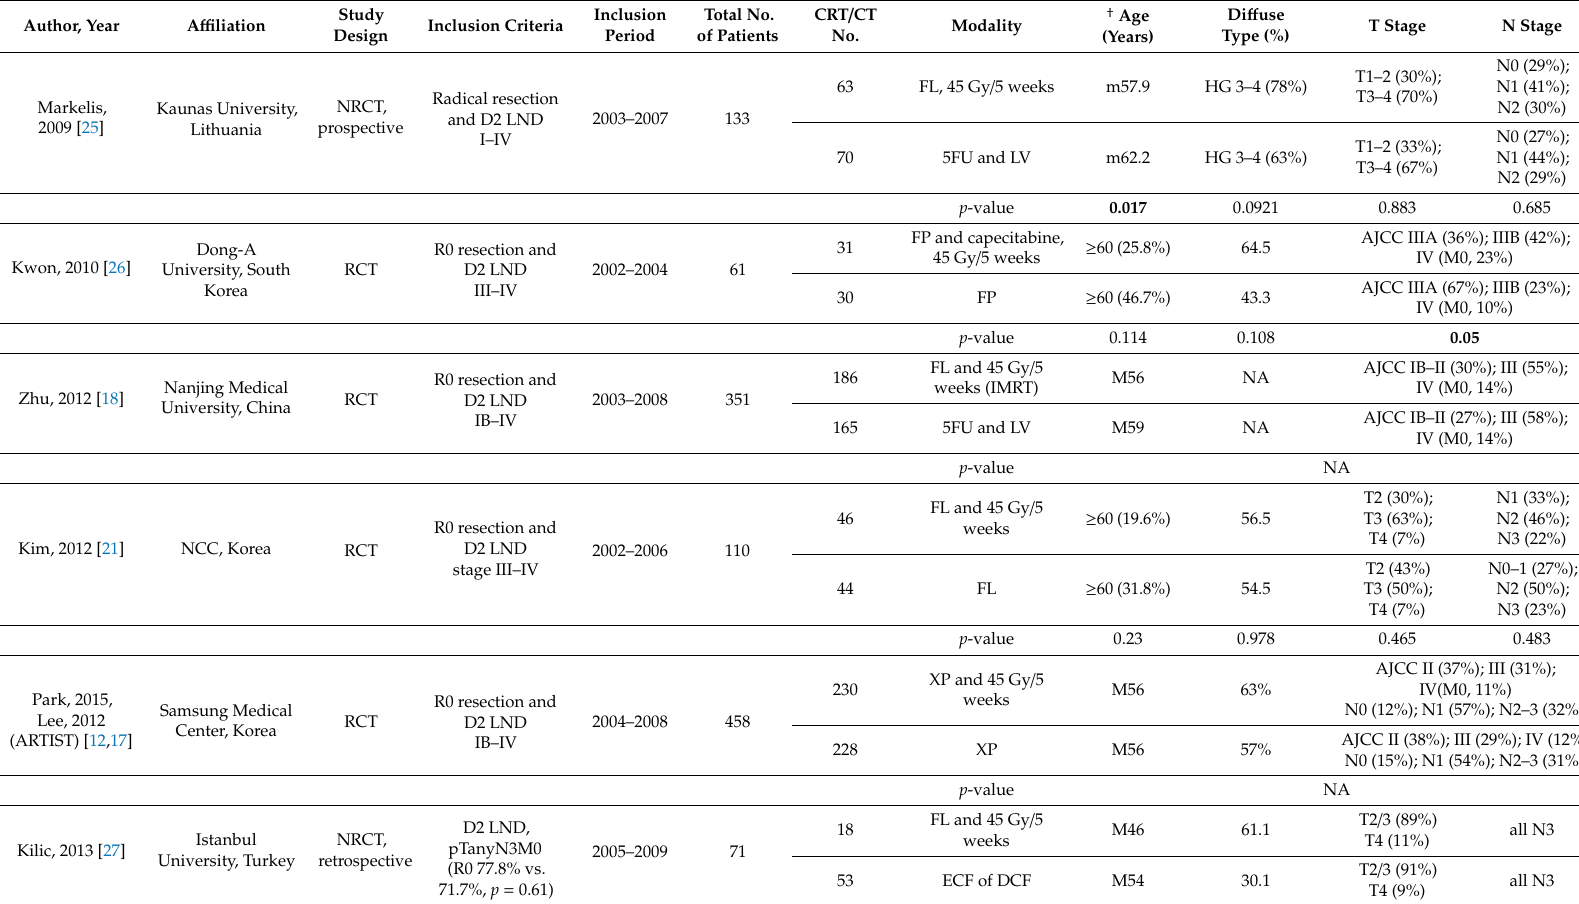
Table 1. Background information of patients in the included